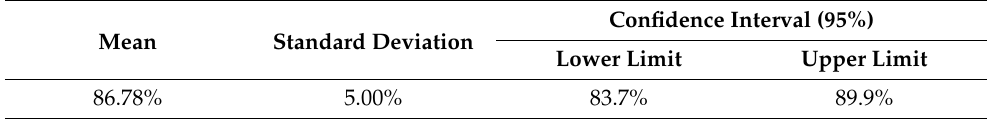
Figure 13. Coincidence between two images. Table 8. Image coincidence rate of the simulator and real flight.